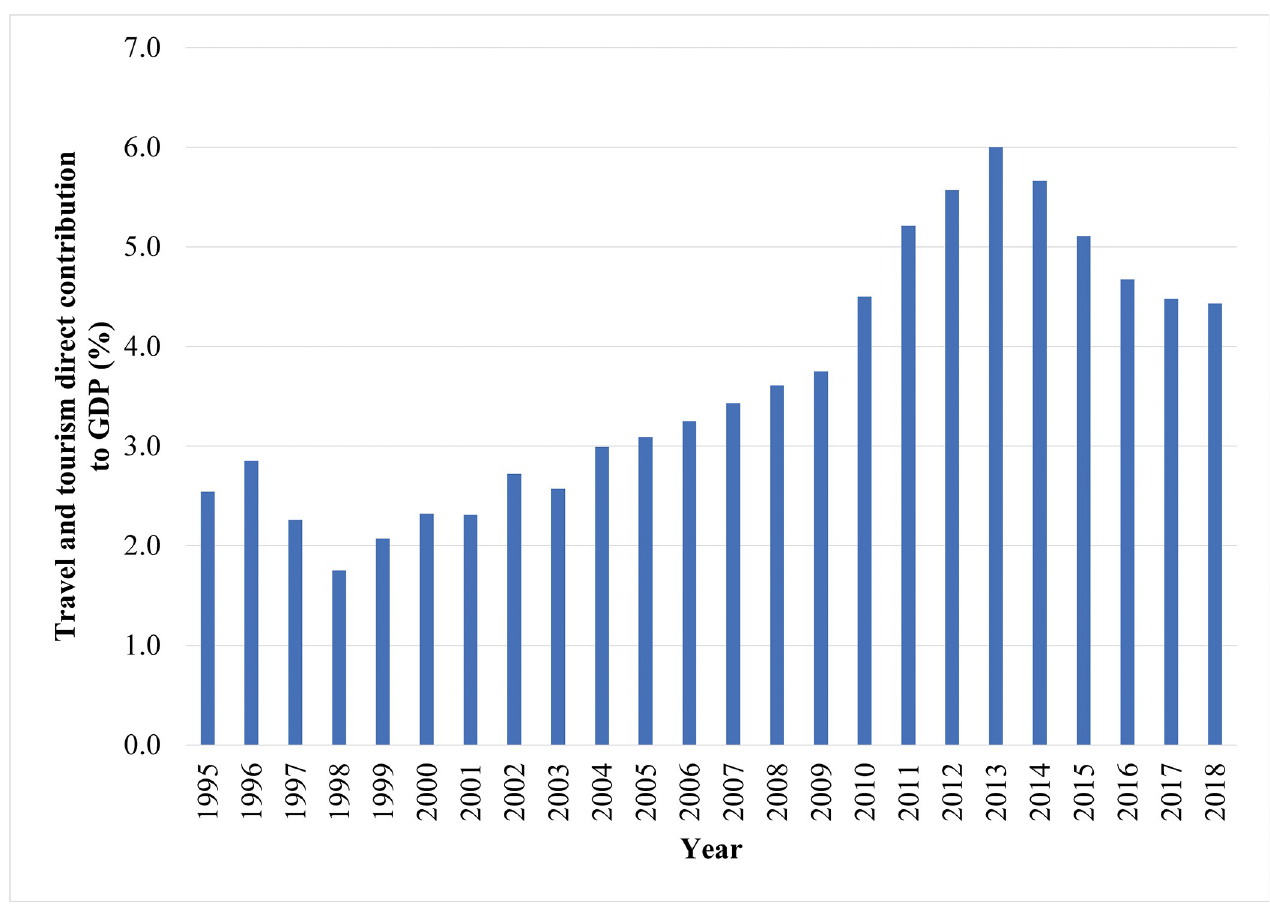
Fig 2. The contribution of the travel and tourism sector to Hong Kong’s gross domestic product, 1995–2018. Data source: World Travel & Tourism Council.